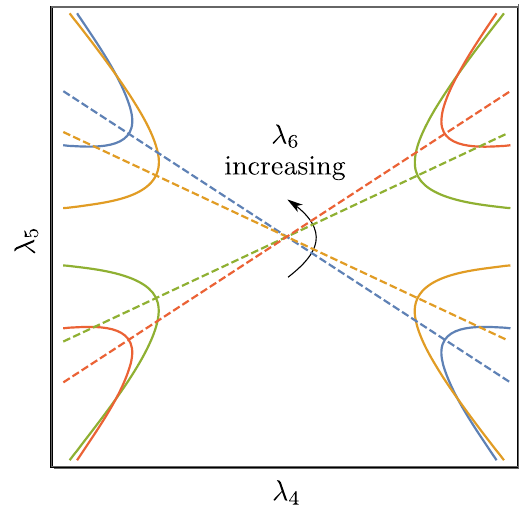
= 125 . 18 GeV. Notice h